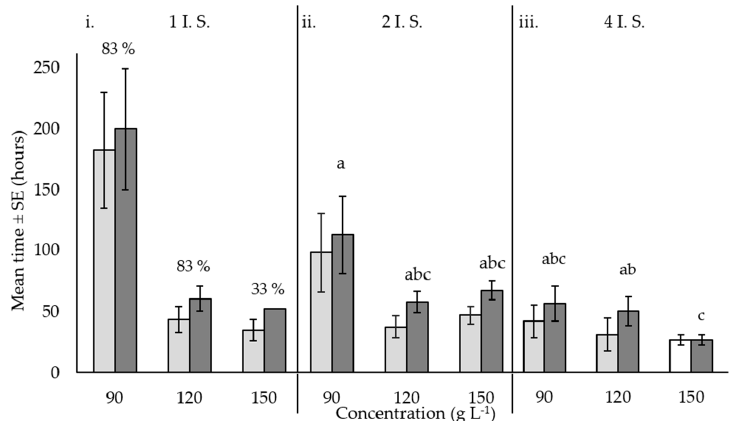
Figure 1. The effects of citric acid concentration and the number of injections. Mean time to immobility ( ) and to death ( ) ± standard error for Acanthaster cf. solaris injected with 20 mL of citric acid and seawater solution at concentrations of 90, 120, and 150 g · L − 1 in one ( i ), two ( ii ) and four ( iii ) injection sites (I.S.). Numbers above bars represent total percent mortality; where no numbers are shown, mortality was equal to 100%. For the 150 g · L − 1 , 4 I.S. treatment, time to immobility was assumed to equal time to death ( ). Six replicates per treatment combination were used. Letter notations above bars (a, b, c) indicate Tukey’s post-hoc groupings between injection site treatments and concentrations for time to death. Different letters indicate significant differences among treatments.